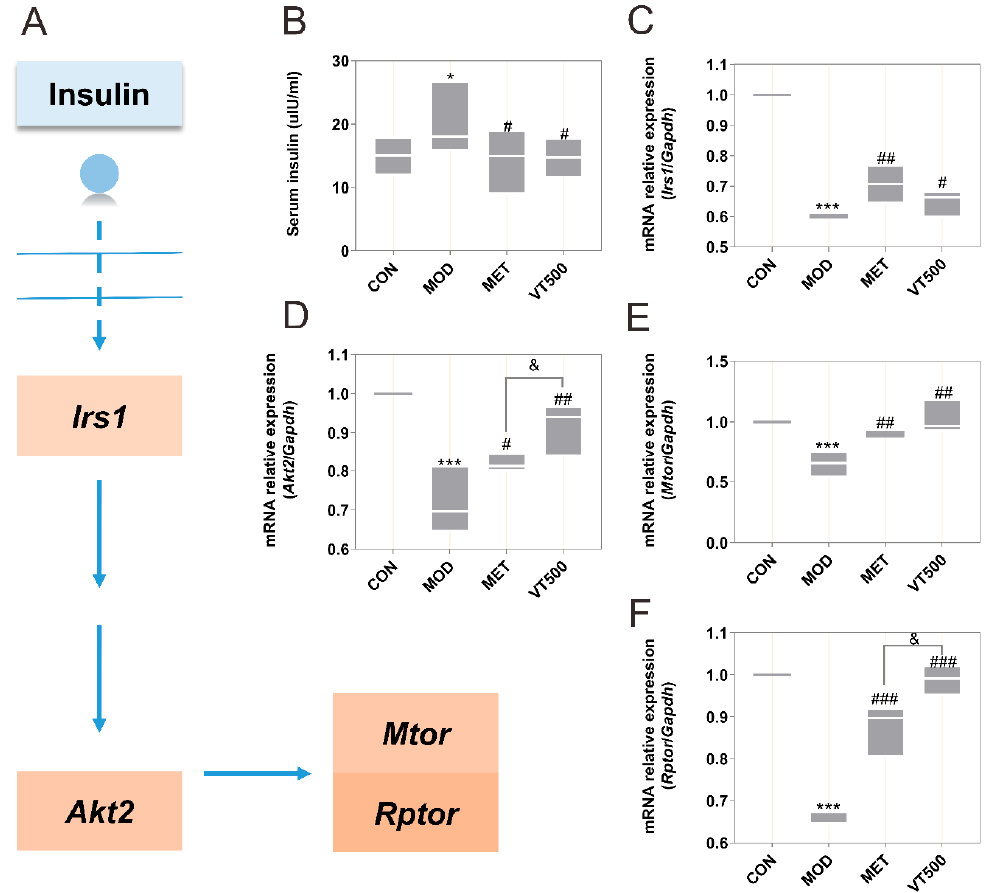
Figure 5. The e ff ect of VT on the expression of genes involved in Akt signaling pathway. Insulin receptor substrate 1 ( Irs1 ), RAC-beta serine / threonine-protein kinase ( Akt2 ), mammalian target of rapamycin ( Mtor ), and regulatory-associated protein of Mtor ( Rptor ) were examined by quantitative real-time reverse transcription polymerase chain reaction (qRT-PCR), and the glyceraldehyde-3-phosphate dehydrogenase ( Gapdh ) gene, as a standard internal reference gene, was simultaneously examined for qRT-PCR normalization. Schematic diagram of the indicators related to the Akt signaling pathway in this study ( A ); the level of serum insulin in all groups ( B ); mRNA expression of Irs1 ( C ), Akt2 ( D ), Mtor ( E ) and Rptor ( F ) in the liver of each group. The data are presented as floating bars (min-max), and the CON group was used to standardize. * p < 0.05, *** p < 0.001 in comparison to the CON group, # p < 0.05, ## p < 0.01, ### p < 0.001 compared to the MOD group, & p < 0.05